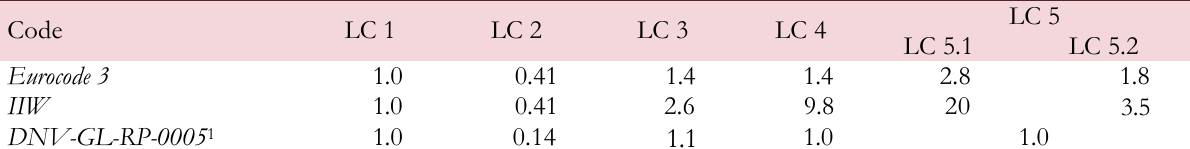
Table 2a: Normalized effect of stress multiaxiallity on fatigue damage predicted using selected codes – Comparison between the different load